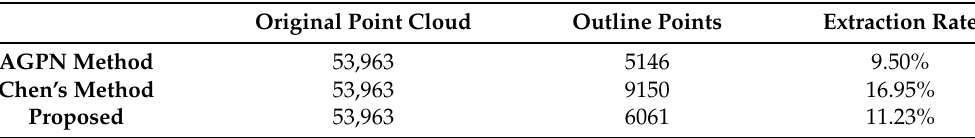
Table 10. Comparison of the extracted feature (fold and boundary) points using the three methods for the “3S”